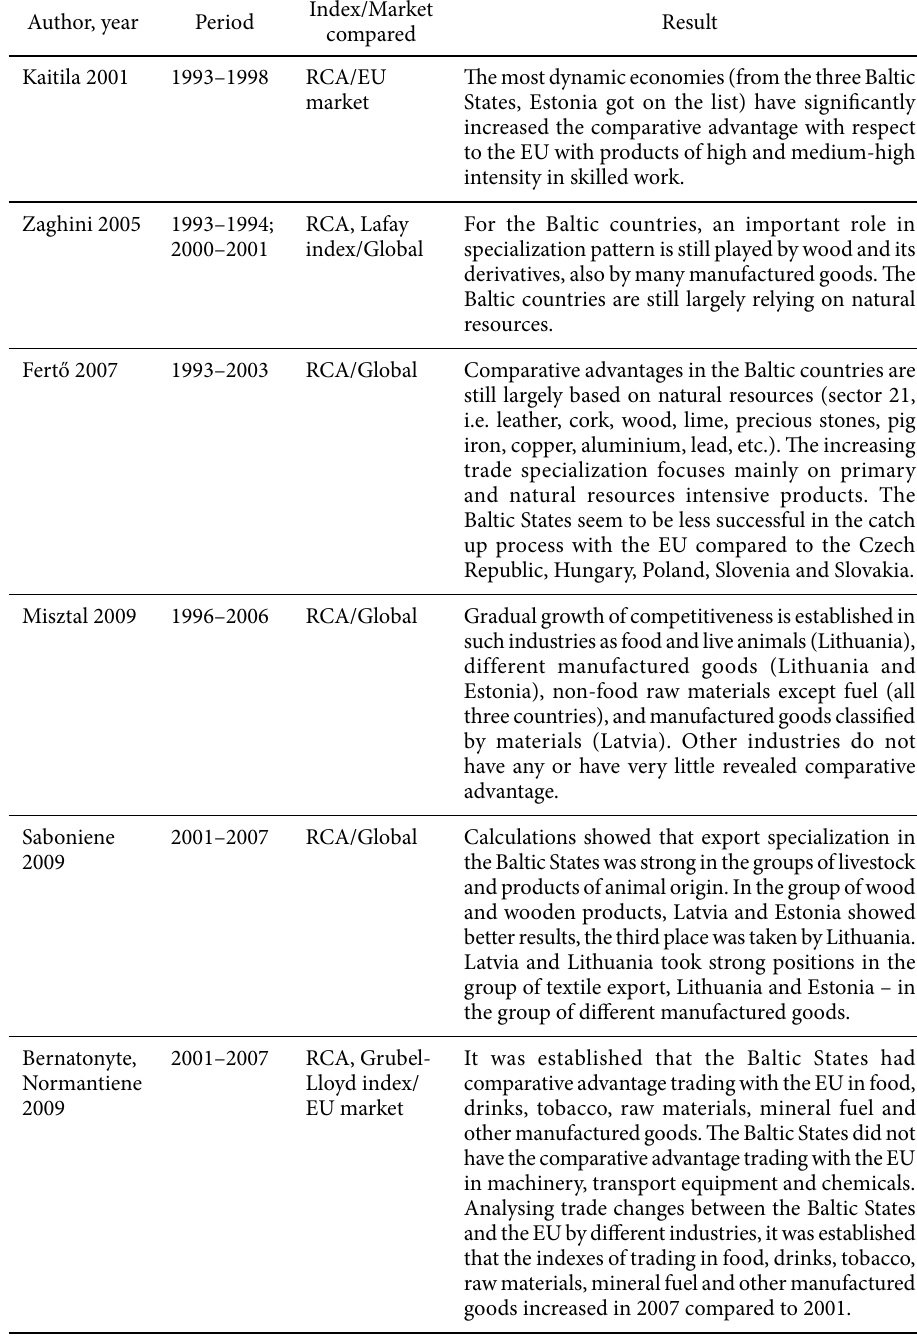
table 1. summary of the research results on the industry competitiveness of the Baltic states author,